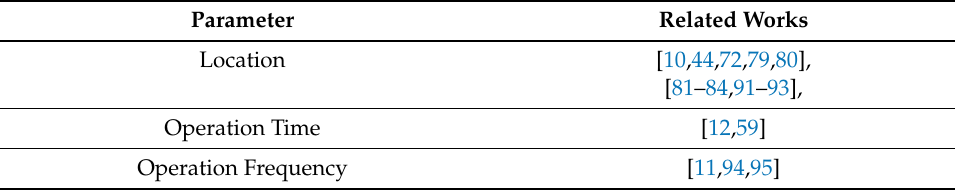
Table 3. Classification of obfuscation-based schemes for privacy in